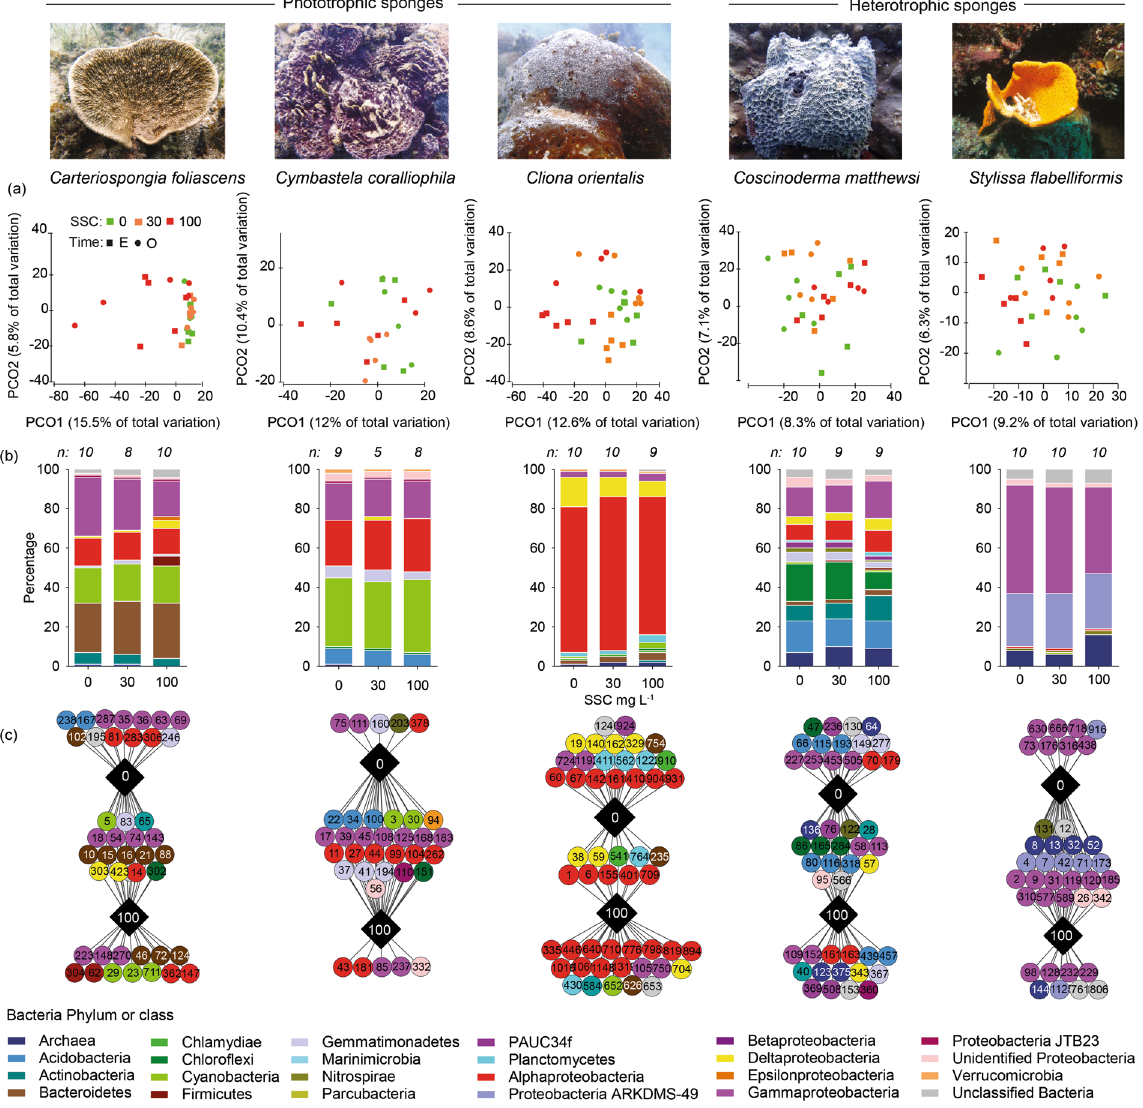
Figure 4. Microbial responses to SSCs. ( a ) Principal coordinate analysis plots for all species and treatments after the 28 d experimental period (E) and 14 d observational period (O), ( b ) Average relative abundance of each bacteria phylum (and class for Proteobacteria ) using OTUs representing greater than 1% of the community for each treatment across both sampling times, ( c ) Cytoscape networks of the microbiome community in all species at 0 and 100 mg L − 1 of SSC across both sampling times. Circles correspond to different OTUs (with OTU numbers) and colours relate to their phylum or class level in the case of